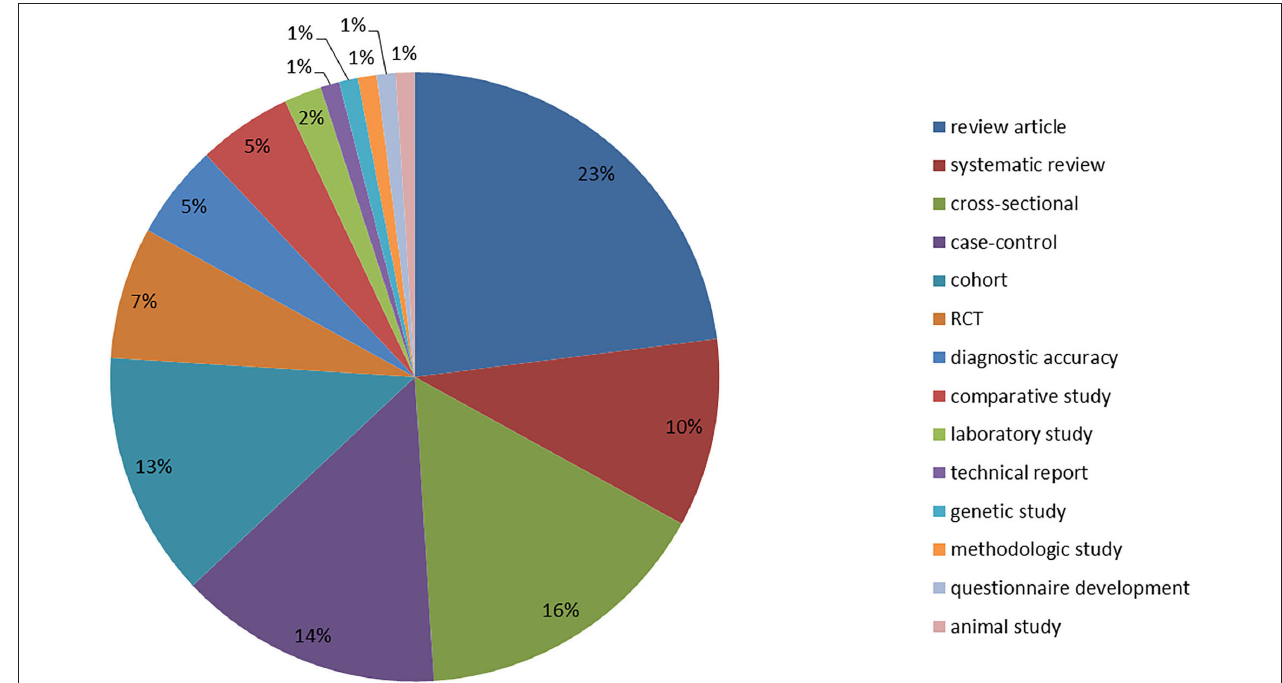
FIGURE 2 | Percentage distribution of study types. Some of the studies could not be referred to a specific study type, thus they were clustered based on the content, e.g., diagnostic accuracy, questionnaire development, and review article (non-systematic reviews of any kind). RCT, randomized controlled trial.